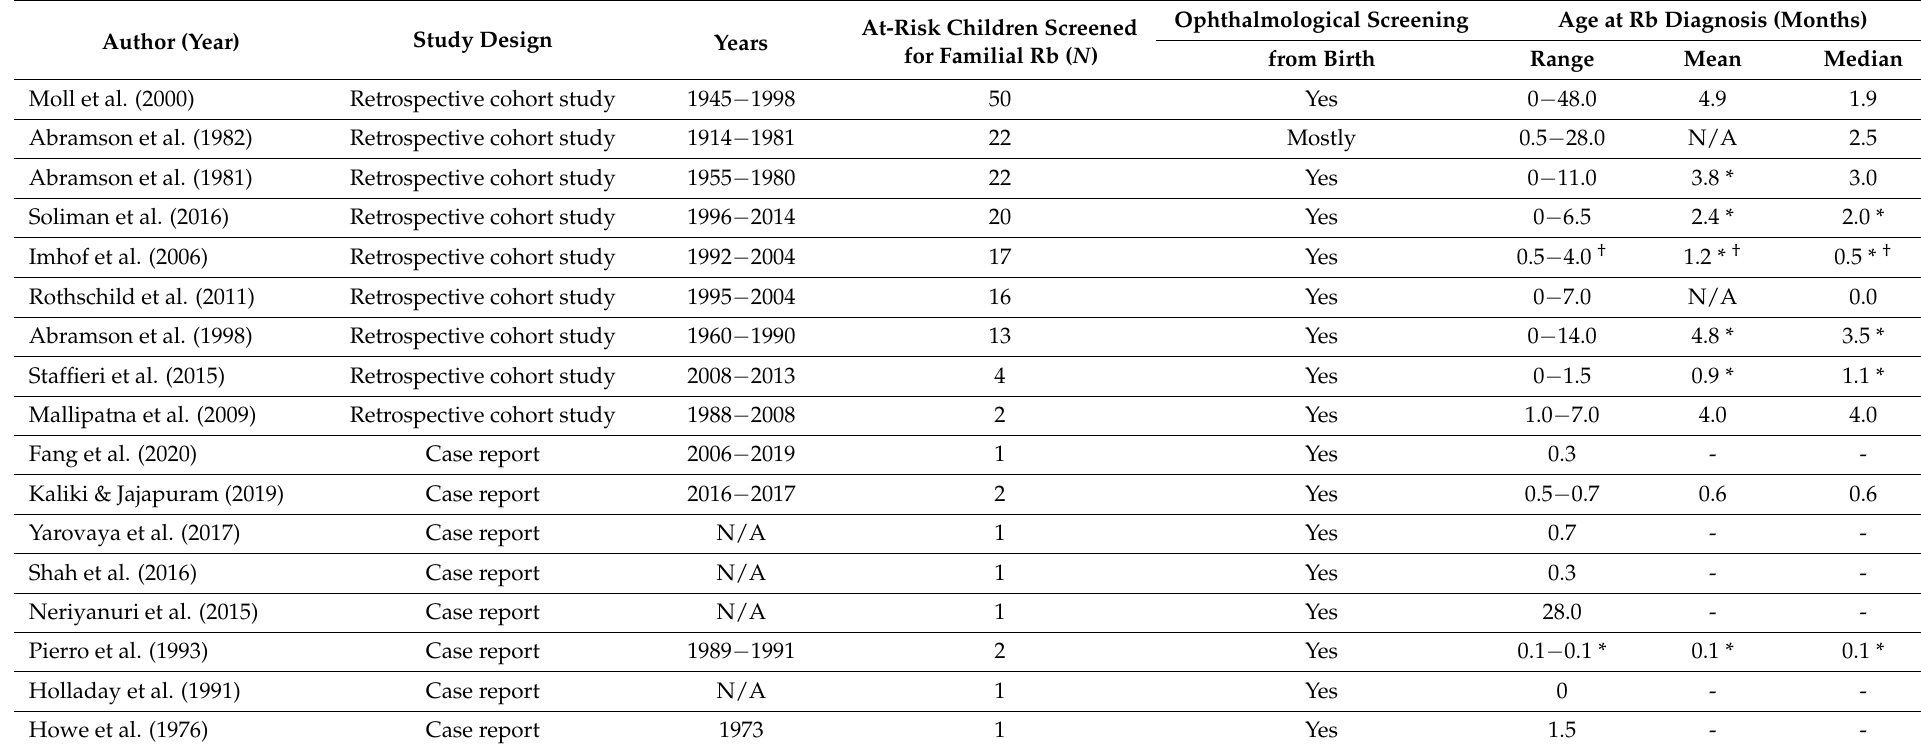
Table 1. Age at familial retinoblastoma diagnosis in patients screened from